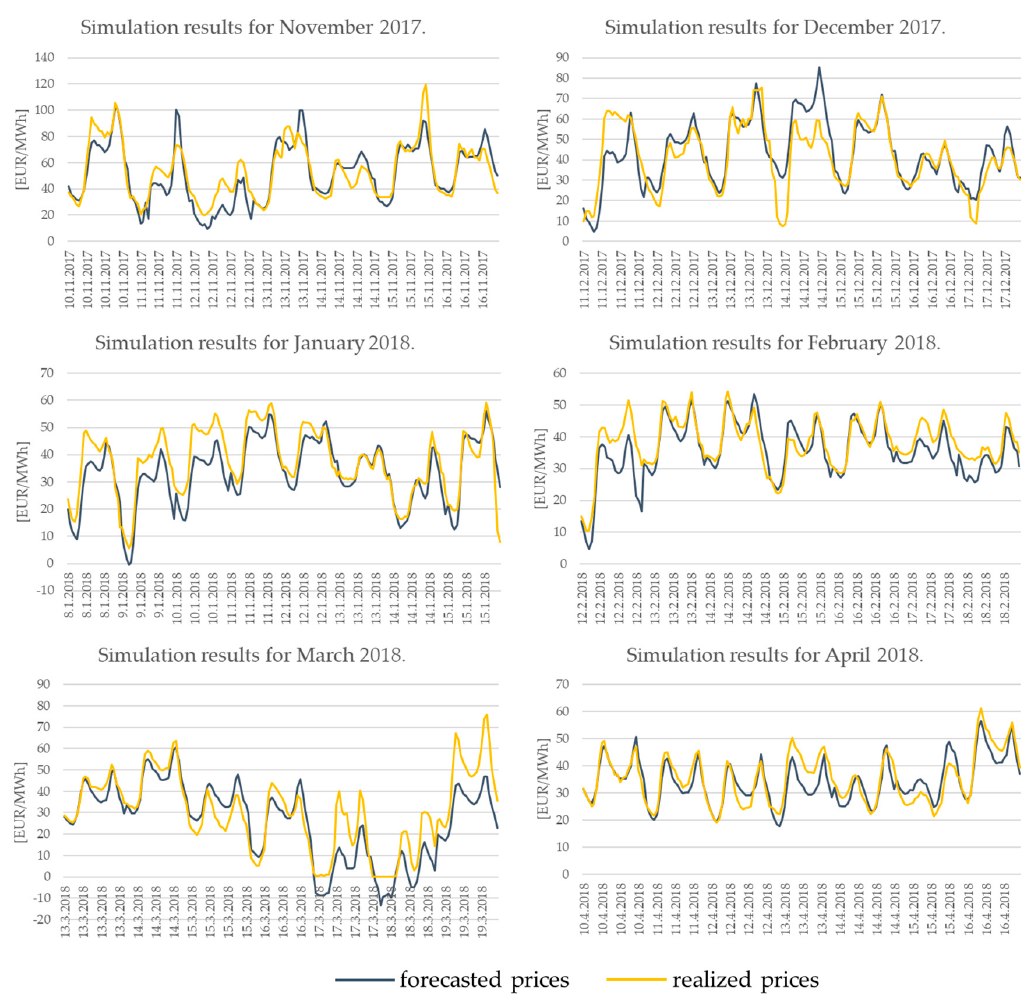
Figure 15. Forecasted and actually realized hourly prices in first forecasting interval for the period from November 2017 to April 2018.